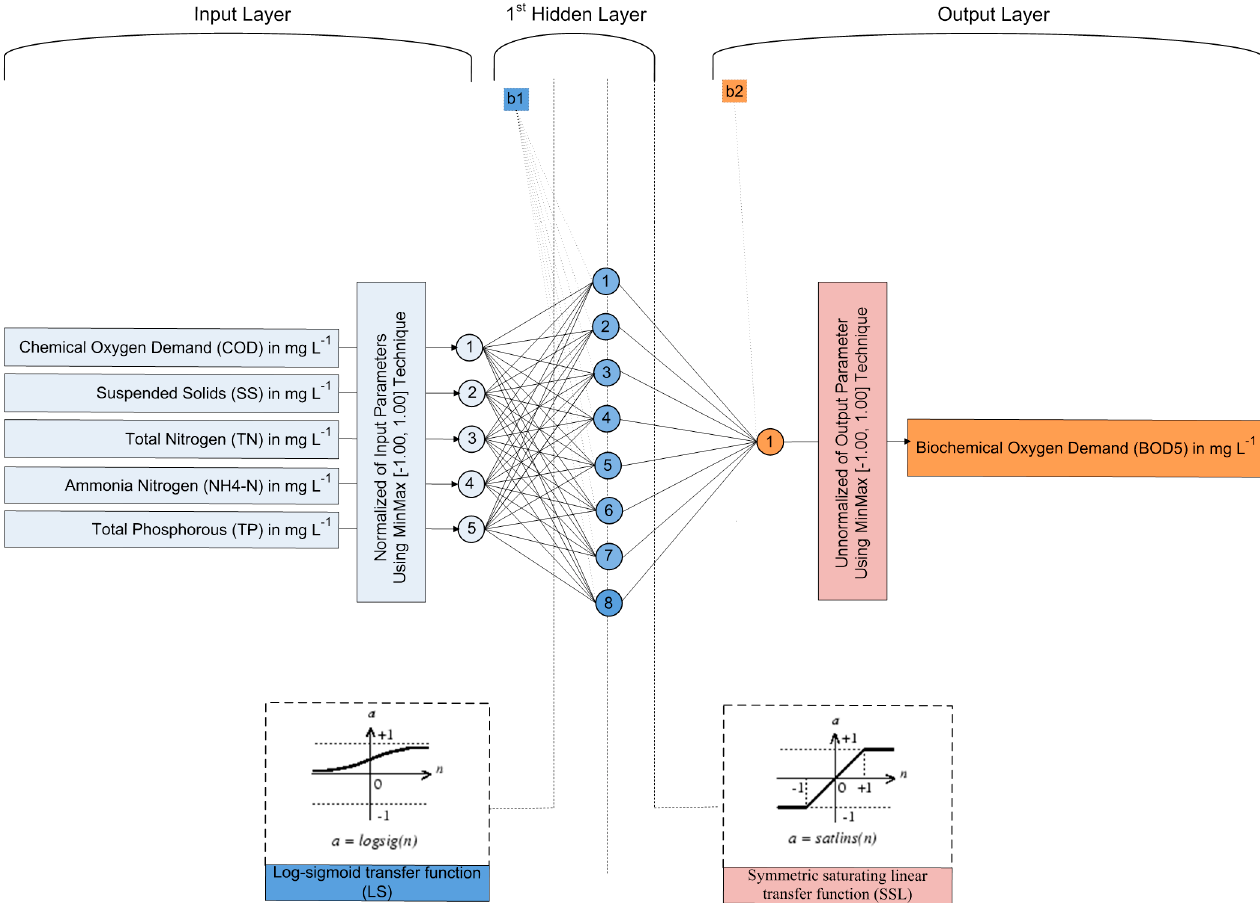
Figure 5. Architecture of the optimum ANN LM 5-8-1 model. Table 7. Summary of prediction capability of the optimum ANN LM 5-8-1 model.